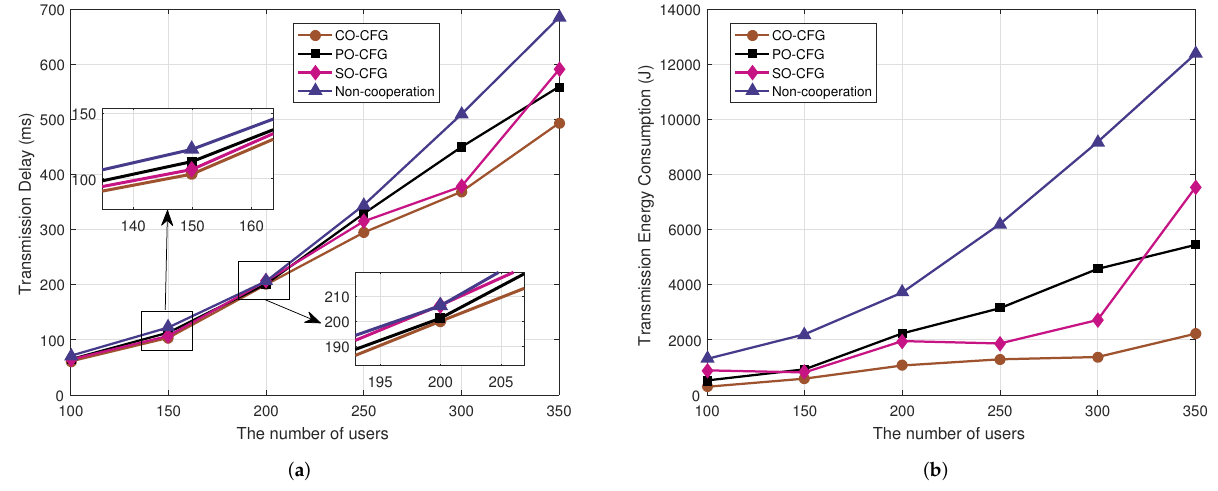
Figure 6. Impact of increasing the number of users on ( a ) system transmission delay and ( b ) system transmission energy